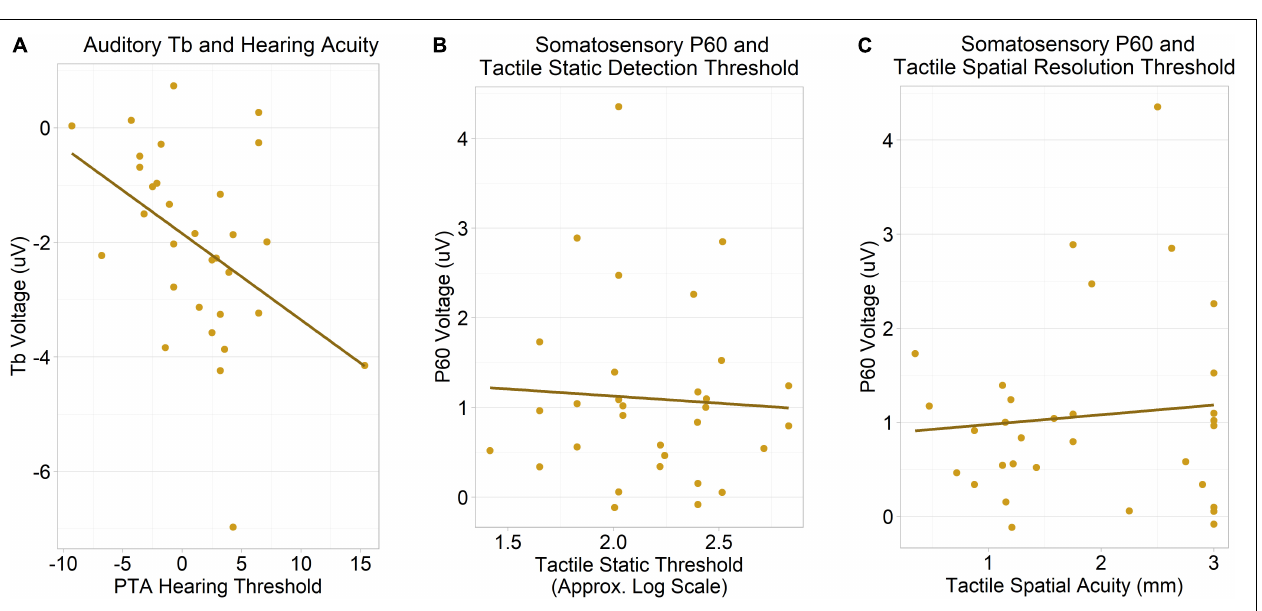
FIGURE 6 | (A) A negative correlation was observed between auditory Tb amplitudes (averaged across hemispheres) and pure tone average hearing thresholds (averaged across ears), corrected p = 0.04. Despite the apparent outliers, the corrected p -value remained significant when the association was measured ordinally (using Kendall’s τ ). (B) No association between contralateral somatosensory P60 amplitudes and tactile static detection (Von Frey hair) thresholds was observed. (C) No association between somatosensory P60 amplitudes and tactile spatial resolution (JVP dome) thresholds was